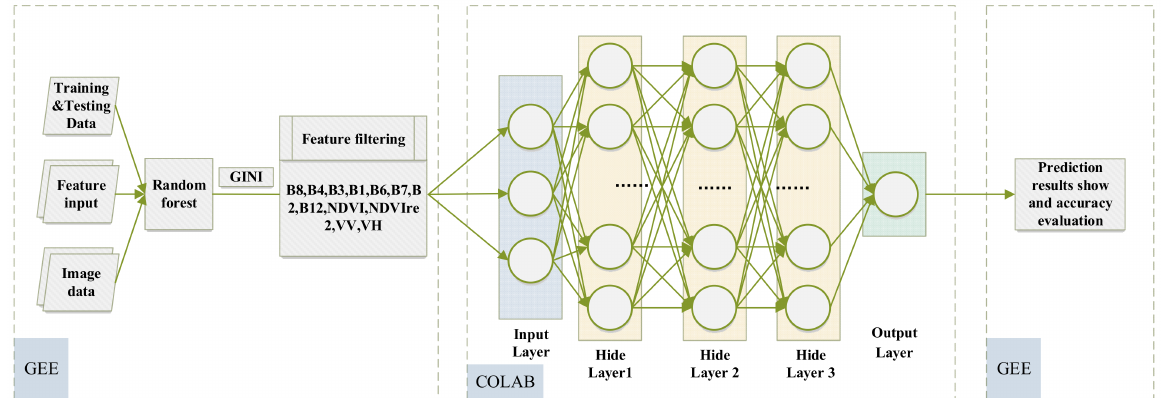
Figure 7. RF+DNN classification method flowchart. This flow chart illustrates the overall framework of the RF+DNN classification method proposed in this